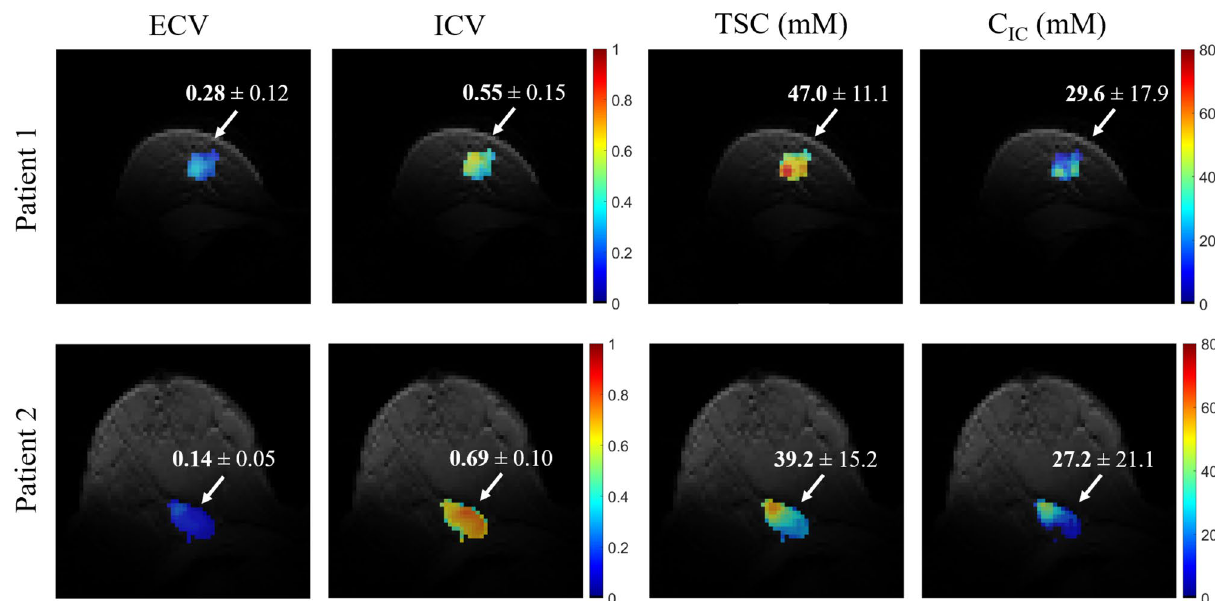
Figure 5. Quantitative maps in a post-menopausal 51-years-old patient with triple negative breast cancer (Patient 1) and in a post-menopausal 58-years-old patient with triple negative breast cancer (Patient 2). In patient 1: average ECV and ICV in the lesion were respectively 0.28 ± 0.12 and 0.55 ± 0.15. TSC in the lesion was 47.0 ± 11.1 mM, which was approximately double the TSC measured in contralateral healthy glandular tissue ( 23.0 ± 7.6 mM, not visible in the figure) in accordance with previous findings. C IC in the lesion was 29.6 ± 17.9 mM. In patient 2: average ECV and ICV in the lesion were respectively 0.14 ± 0.05 and 0.69 ± 0.10. TSC in the lesion was 39.2 ± 15.2 mM, which was three times higher than in contralateral healthy tissue ( 13.5 ± 7.5 mM). C IC in the lesion was 27.2 ± 21.1 mM. ECV, extracellular volume fraction; ISC, intracellular volume fraction; TSC, total sodium concentration; C IC , intracellular sodium